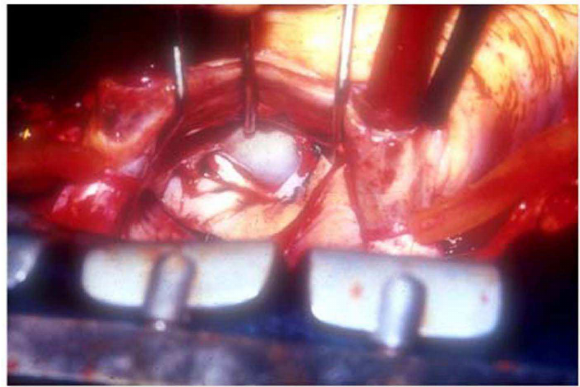
Fig. 13 – Intraoperative surgical aspect of a mitral annuloplasty by the Gregori-Braile ring